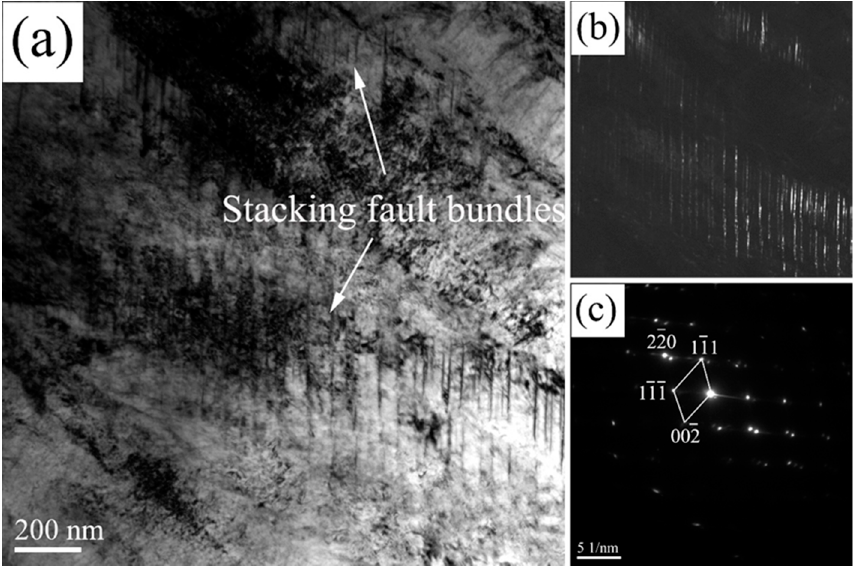
Figure 8. TEM images of the stacking fault bundles in the blocky RA of the 200 °C: ( a ) bright-field image, ( b ) dark-field images, and ( c ) SAED pattern.